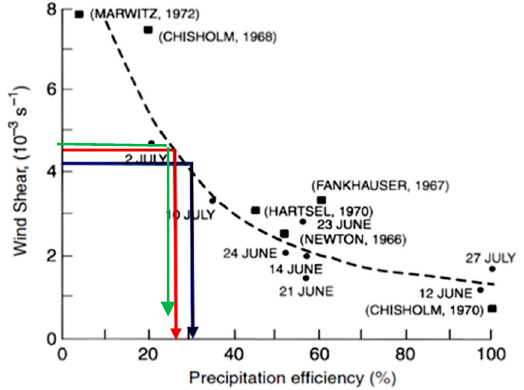
Table 4. Wind shear and precipitation efficiency for the three radio soundings.